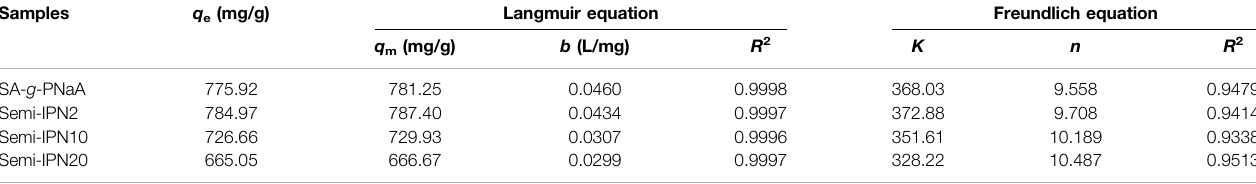
TABLE 1 | Adsorption isotherm parameters for the adsorption of Pb(II) ions onto the hydrogel adsorbent. Samples